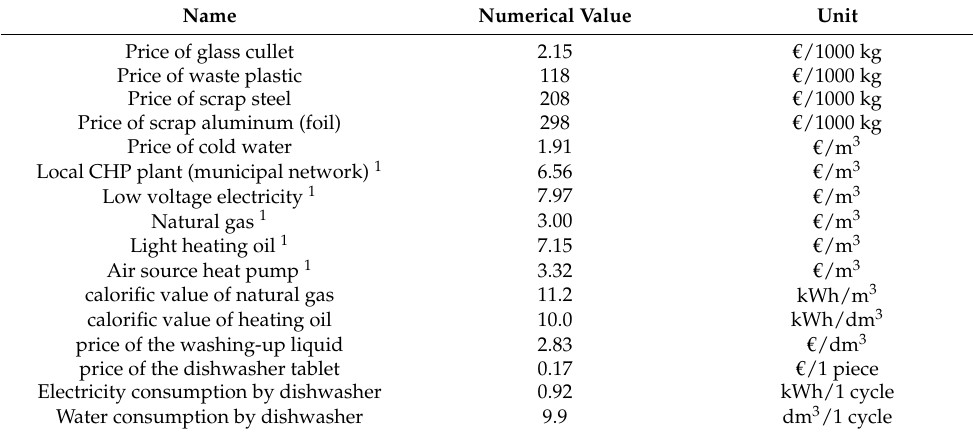
Table 1. Comparison of input